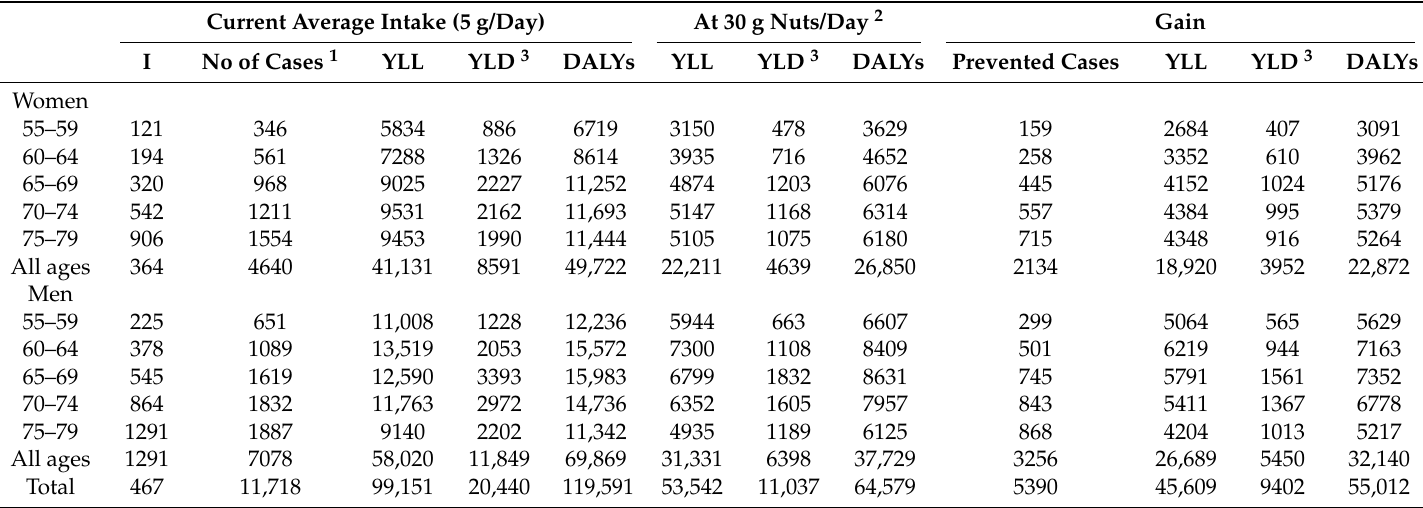
Table 2. Estimated absolute gain in health impact attributable to first incident stroke in the Swedish population aged 55–79 years in 2013, by increasing the nut consumption from current average of 5 g/day to a scenario where everyone consumes 30